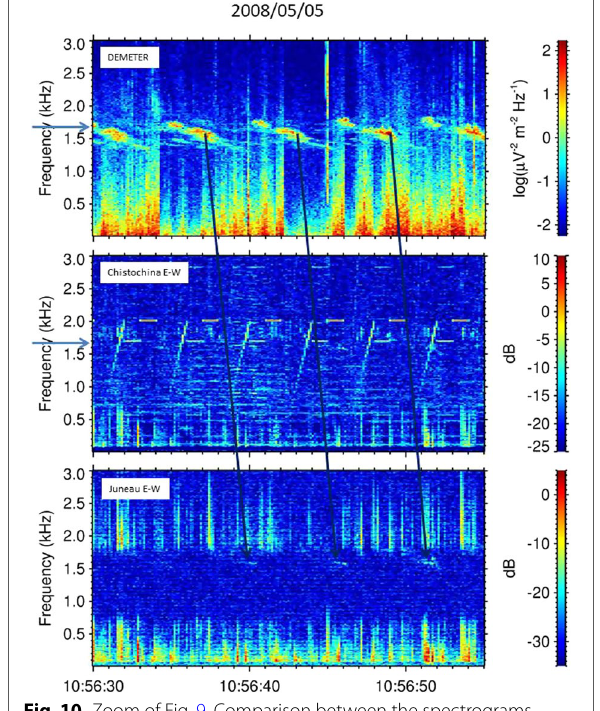
Fig. 10 Zoom of Fig. 9. Comparison between the spectrograms recorded by DEMETER in the Southern hemisphere (top panel), recorded at Chistochina (middle panel), and recorded at Juneau (bottom panel). The power spectral density is color-coded according to the scale on the right. The black arrows indicate the correspondence between emissions seen at Juneau and the same emissions observed by DEMETER